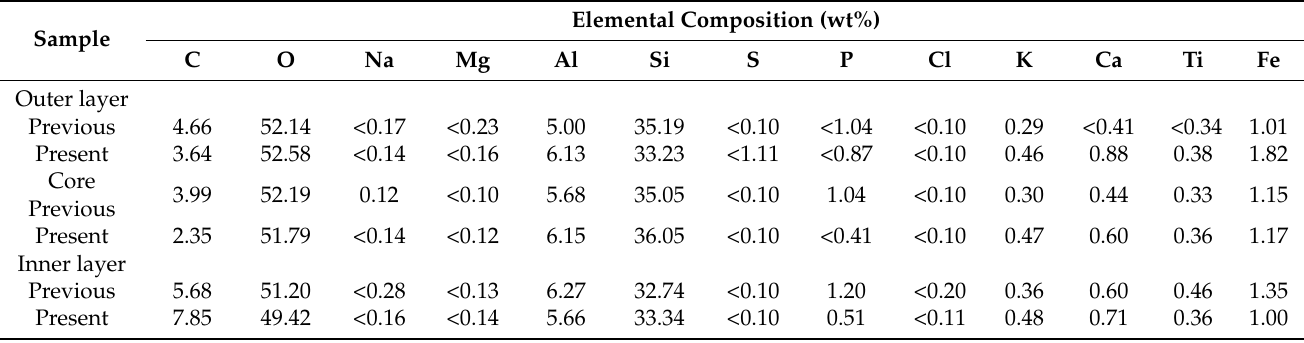
Table 5. Comparison between average elemental compositions of Ban Muang Bua pottery